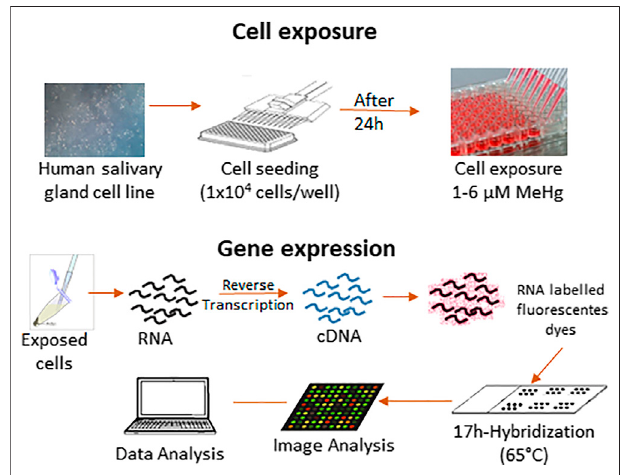
FIGURE 1 | Schematic representation of the research